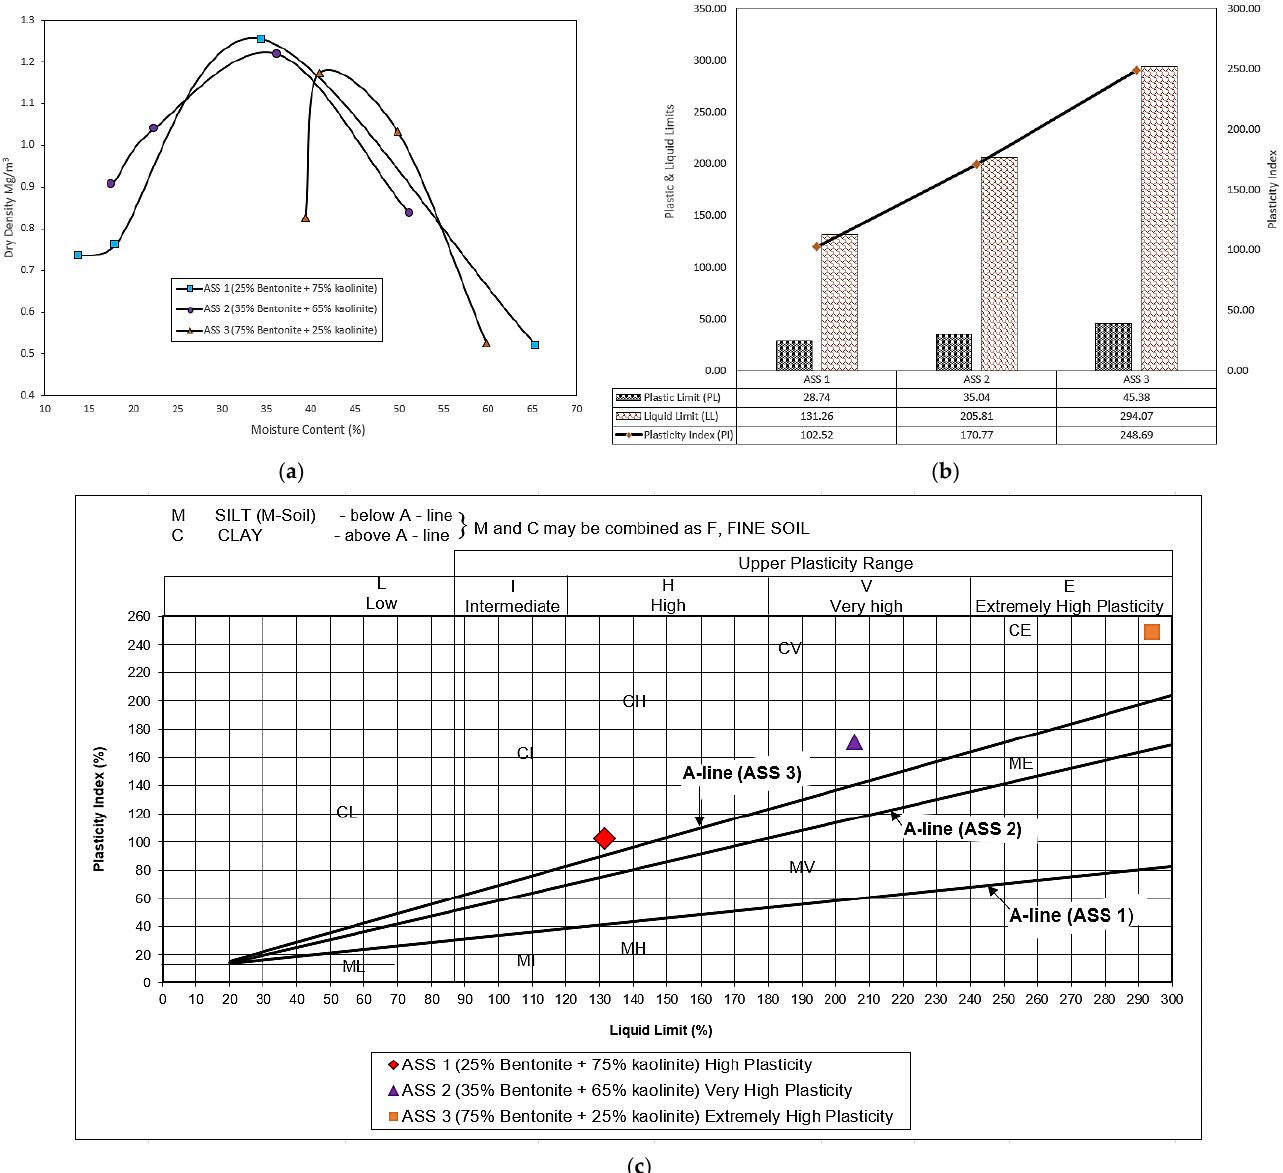
Figure 8. ( a ) Proctor compaction test results; ( b ) Atterberg limit test results against plasticity index; ( c ) plasticity index chat.